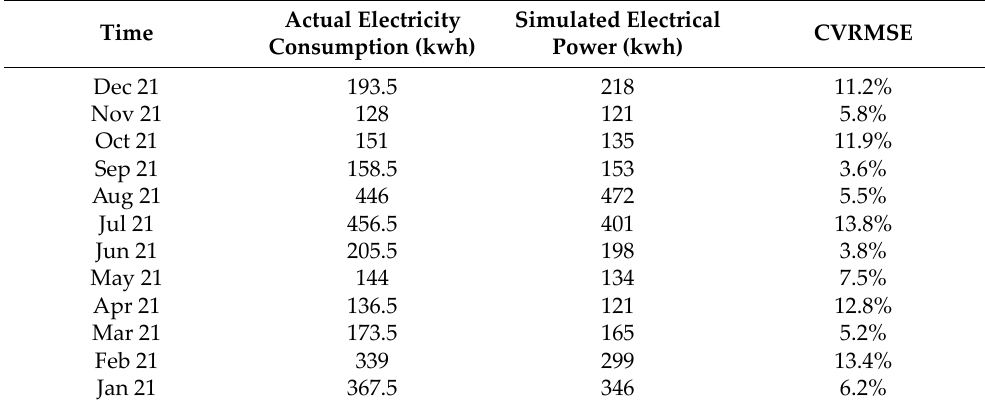
Table 5. Monthly measured and simulated electricity consumption data for residential home.